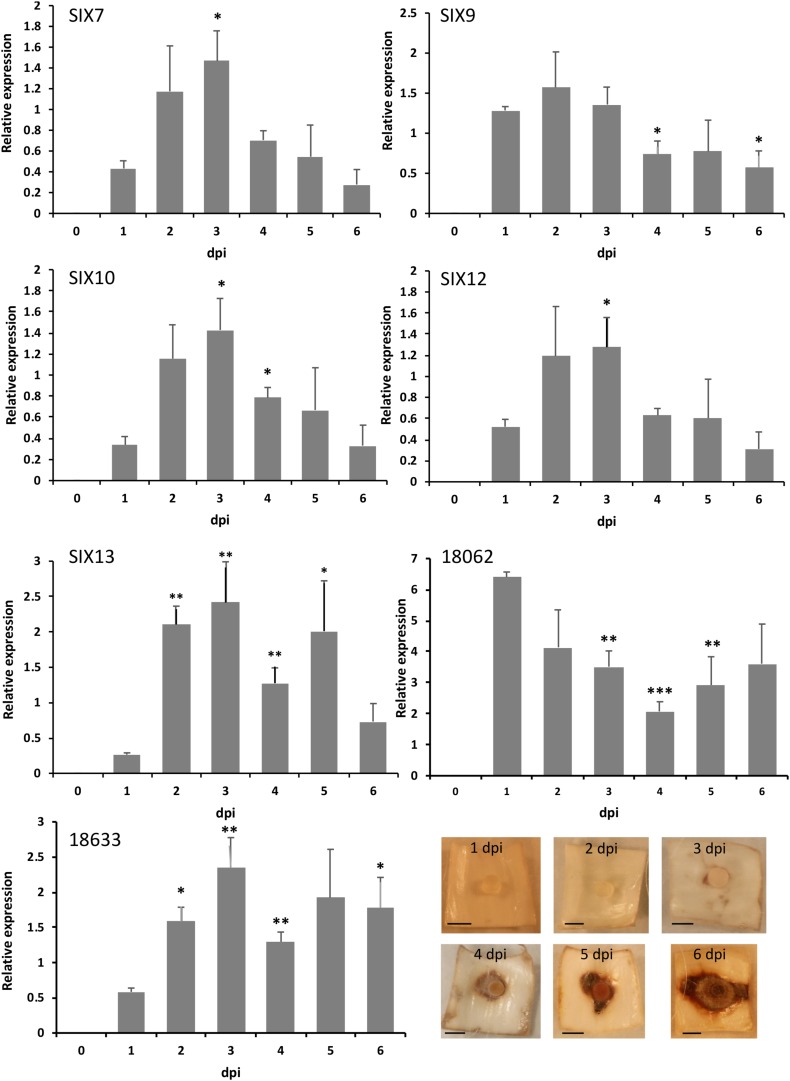
Quantitative expression of SIX genes and two other putative effectors in planta following inoculation of Narcissus (cv. Carlton) scales with isolate FON63. Expression was calculated relative to the geometric mean of translation elongation factor 1-α and β-tubulin. Error bars show the standard error of the mean of four biological replicates; dpi, days post-inoculation. Asterisks indicate expression levels significantly different from 1 dpi based on two-tailed T-tests (∗P < 0.05, ∗∗P < 0.01, ∗∗∗P < 0.001). Images show the progression of disease symptoms at the time-points used for RNA extractions; scale bars are 0.5 cm.